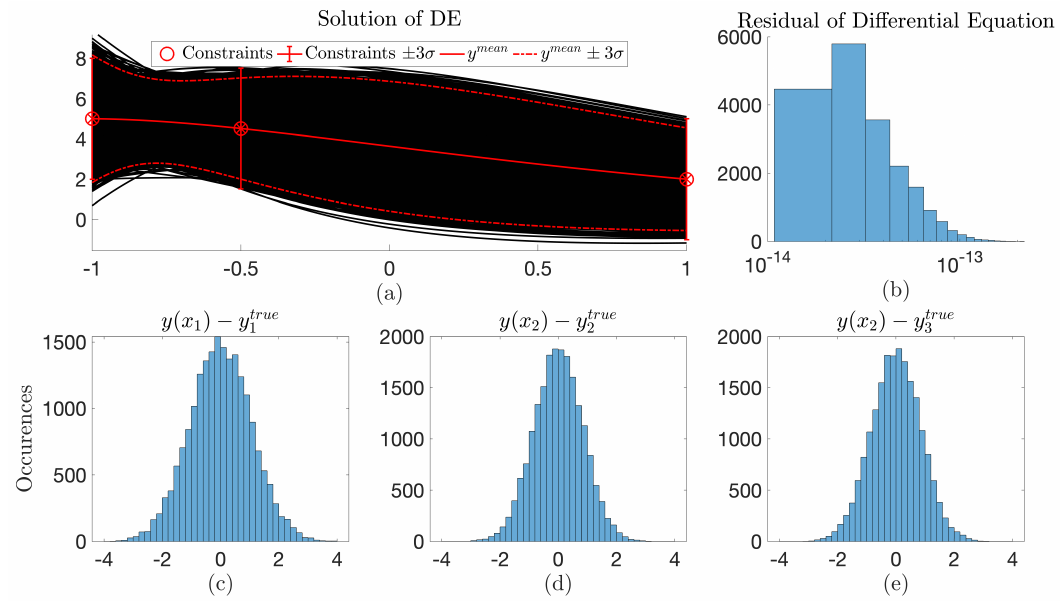
Figure 4. Monte Carlo test for 10,000 trials. Part ( a ) represents the solutions of the differential equation over the varying observed “constraints” with part ( b ) quantifying the accuracy of the solution. Parts ( c )–( e ) represent the distribution of the solution values compared with the true value of the